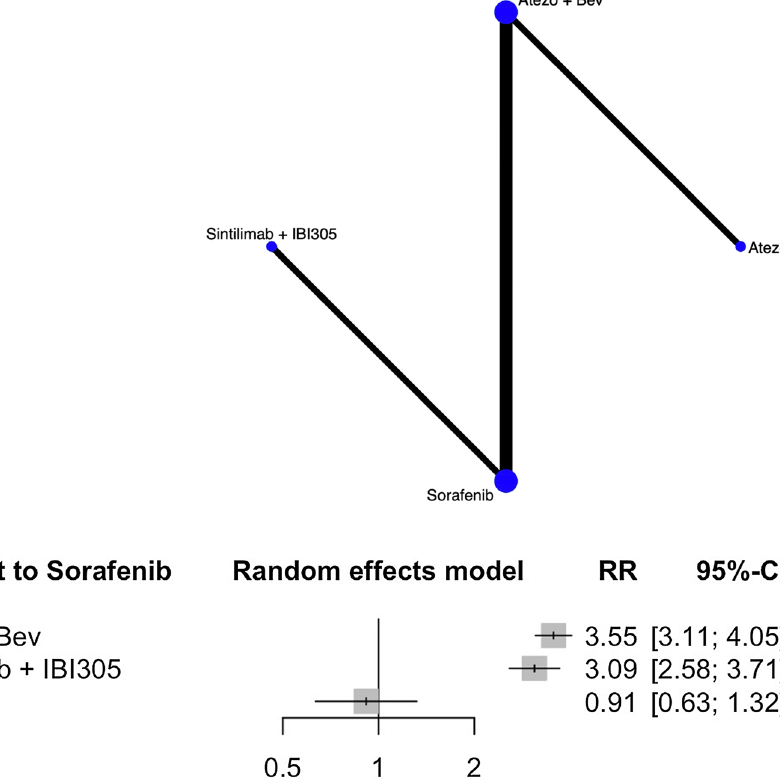
Fig. 10 Network plot of DCR